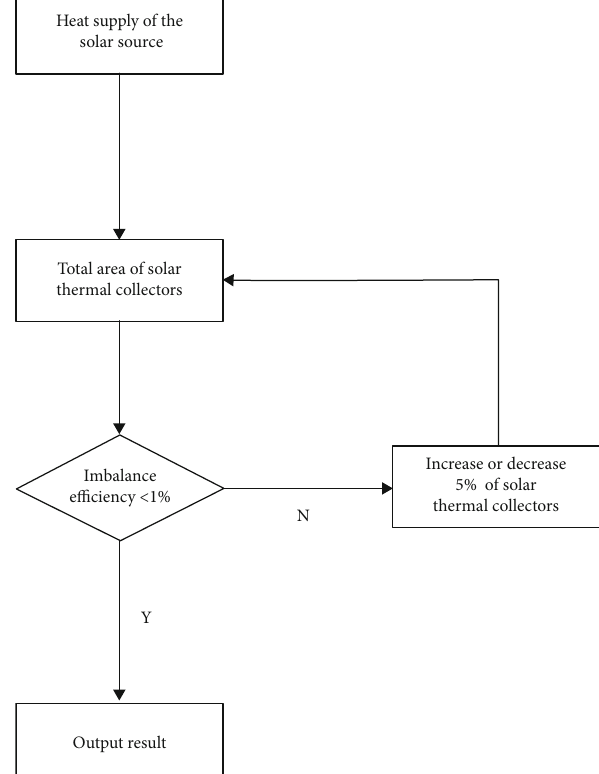
Figure 8: Optimization of solar collector